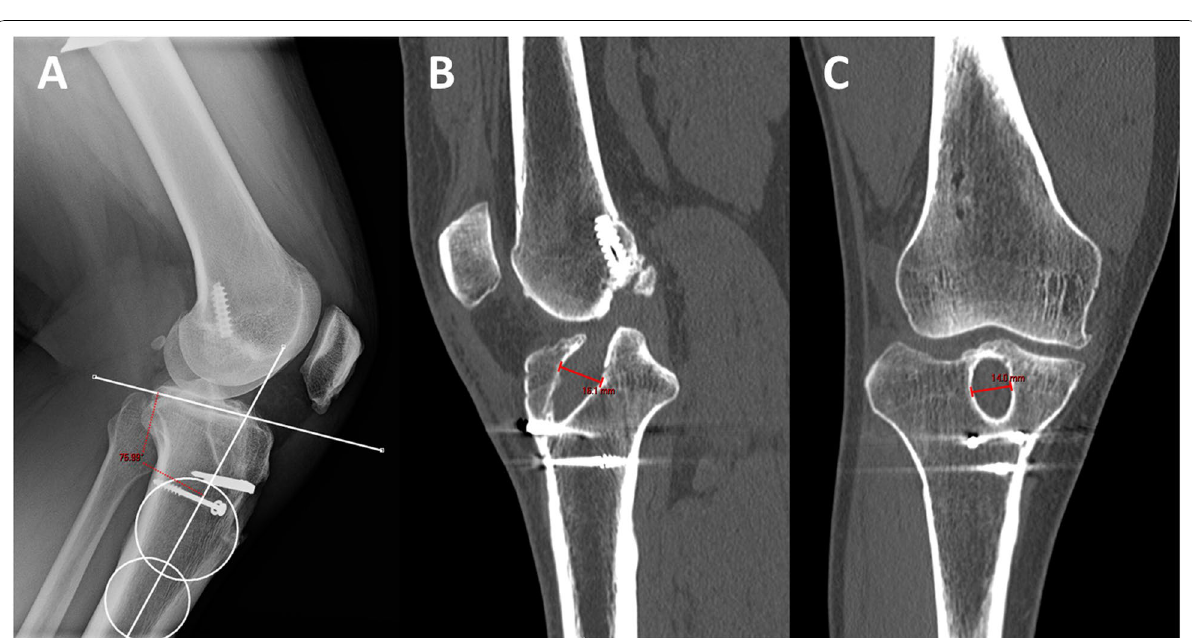
Fig. 8 Preoperative radiograph and CT scan slices showing posterior tibial slope of 14 degrees ( A ) with tunnel widening of 16 mm on the sagittal ( B ) and 14 mm on the coronal ( C